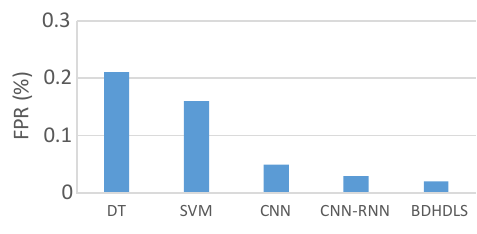
Fig. 14 Number of samples for different intrusive attacks in the DARPA1998